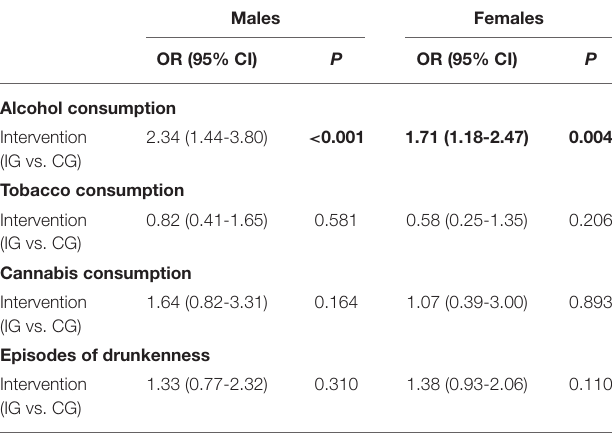
TABLE 4.1 | Gender-specific results of multivariable logistic regression models; Outcomes: alcohol, tobacco, cannabis consumption, and episodes of drunkenness decreased 5 months